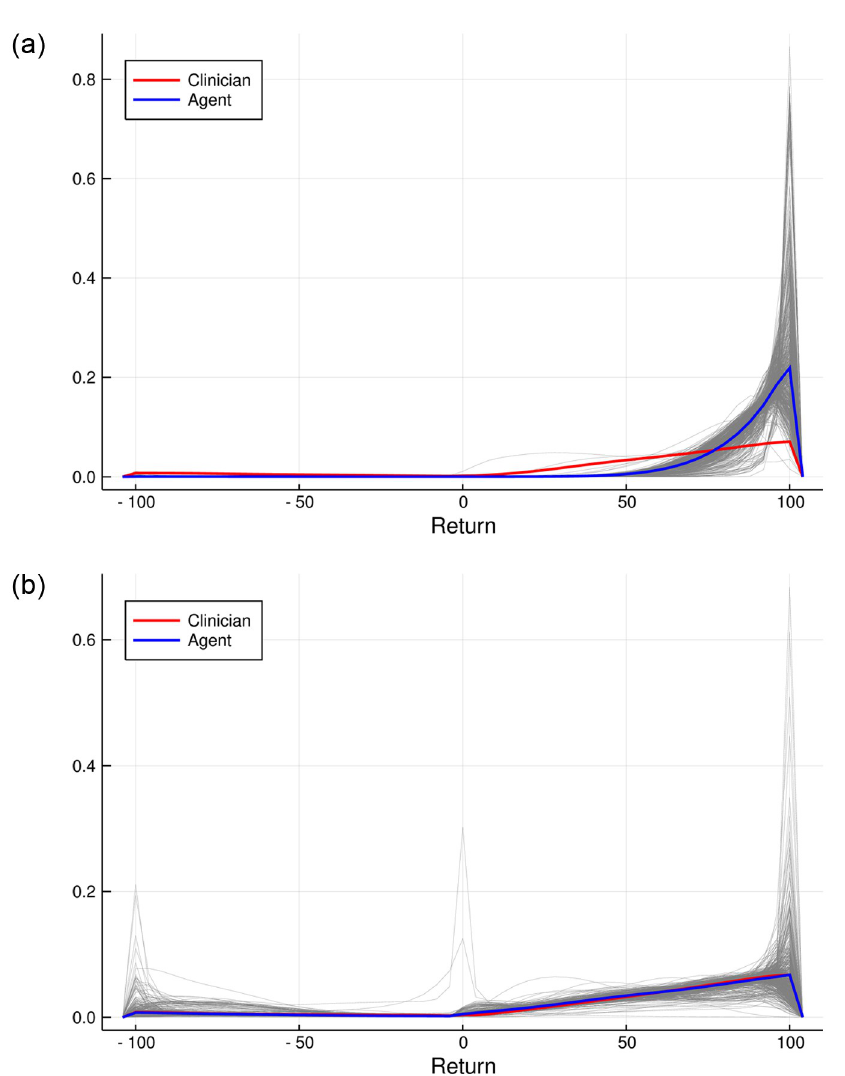
Fig 5. Return distributions of the resulting stochastic policy for all initial states in gray and average return distribution (weighted by the numbers of occurrences as initial states) in blue. The average return distribution of the clinicians’ policy is shown in red for comparison. Left: training simulator; right: test simulator.